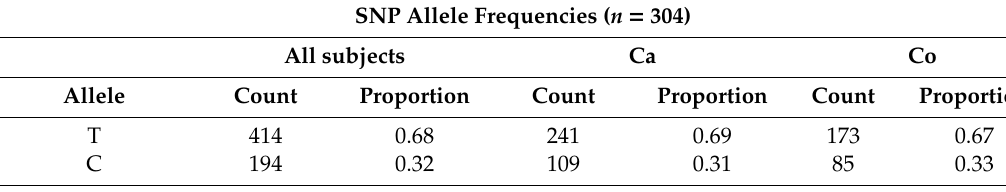
Table 1. The allele, genotype frequencies, the exact test for Hardy–Weinberg equilibrium analysis, and the single nucleotide polymorphism (SNP) association with breast cancer status of rs12976445 miR-125a gene polymorphism. Ca—cases, Co—controls, OR—odds ratio, CI—confidence